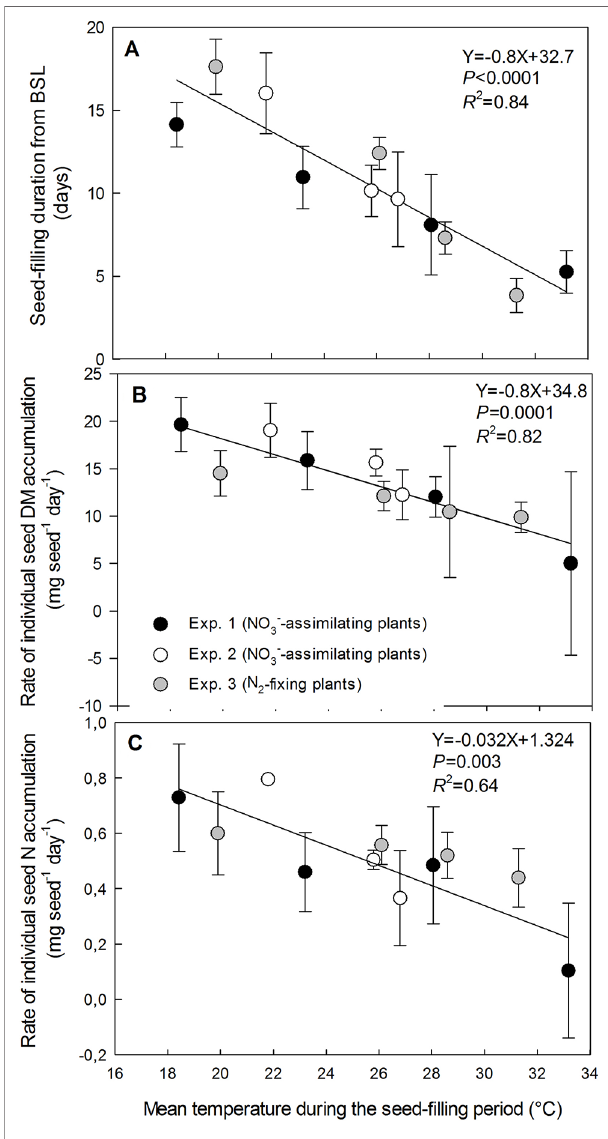
FIGURE 2 | Decrease in seed- fi lling duration (A) , the rate of individual seed dry-matter accumulation (B) and the rate of individual seed nitrogen- accumulation (C) with increasing temperature of the treatments during the seed- fi lling period. The vertical bars represent SE (when larger than symbol). The data were fi tted with a linear